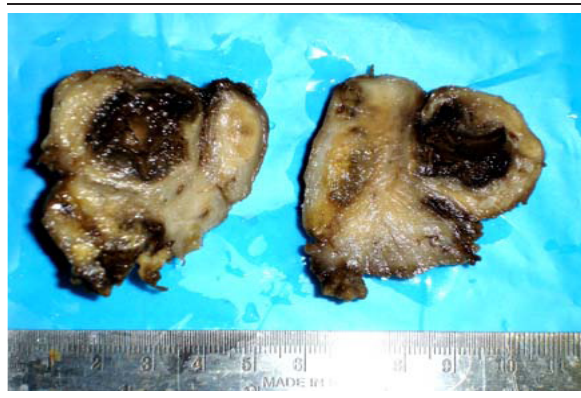
figure 1. Photomicrograph showing numerous non- caseating epithelioid cell granulomas and Langhans giant cells in functionalis layer of endometrium [HandE X100]. Inset shows high power view of a typical granuloma in endometrium [HandE x 400].